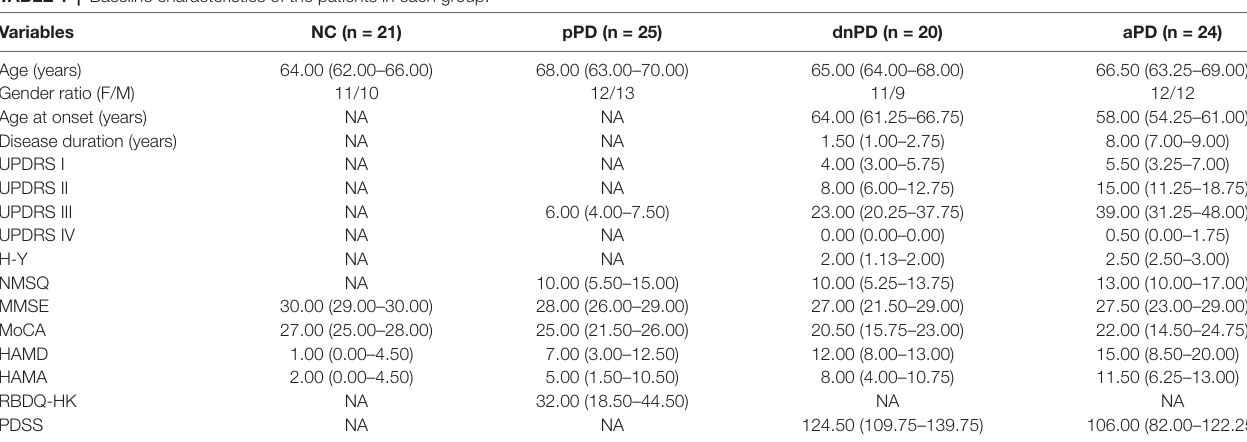
TABLE 1 | Baseline characteristics of the patients in each